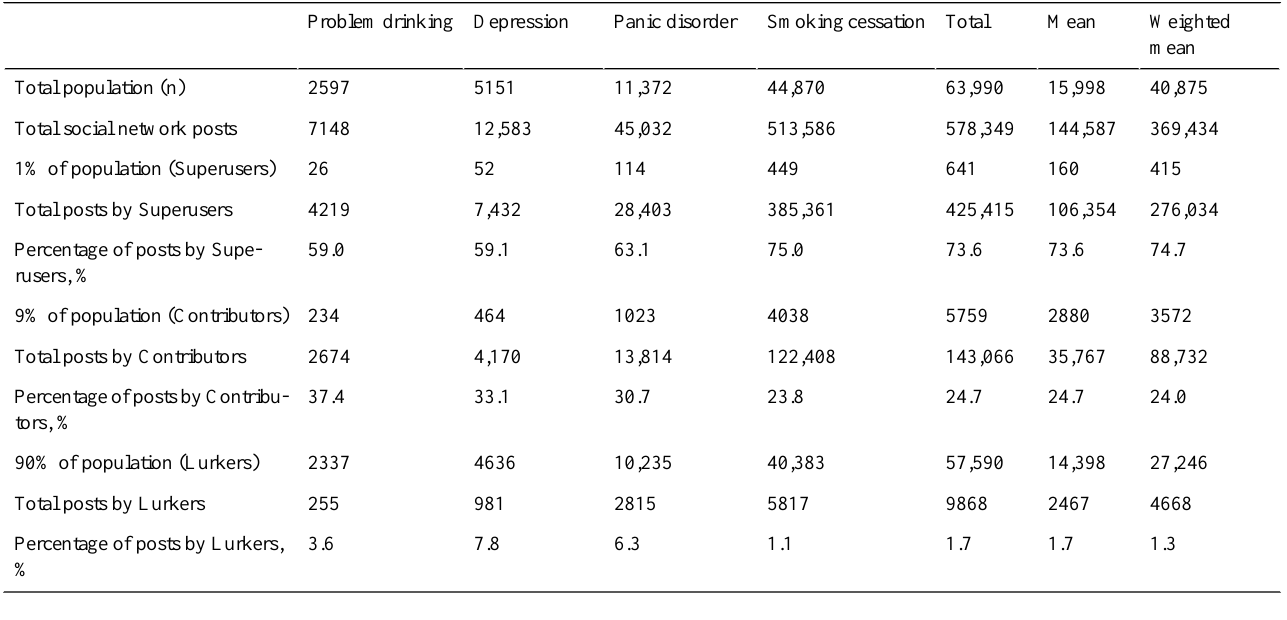
Figure 1. Network content according to the 1%